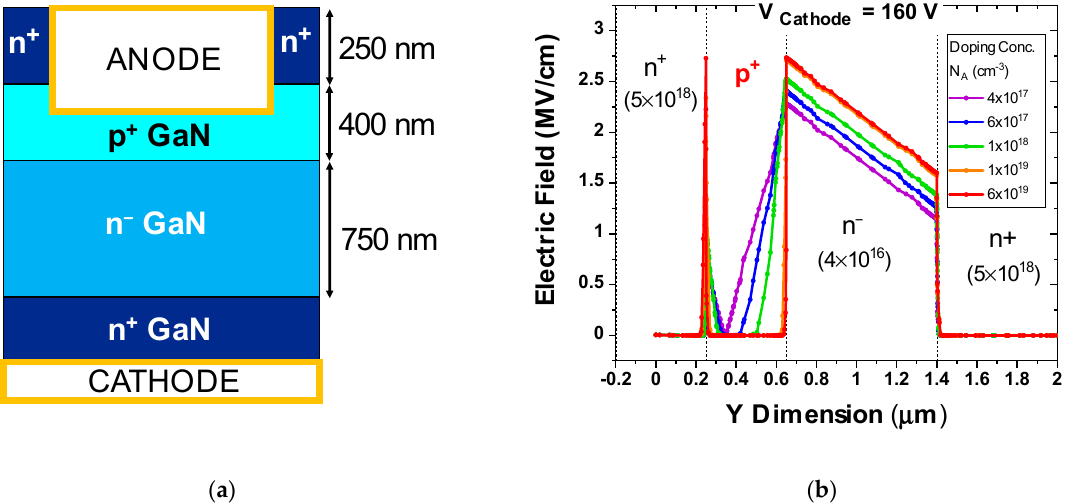
Figure 9. ( a ) Schematic of the simulated structure. ( b ) Electric field profile along the simulated vertical p + n diode for N A = 4 × 10 17 cm − 3 , 6 × 10 17 cm –3 , 1 × 10 18 cm − 3 , 1 × 10 19 cm − 3 , and 6 × 10 19 cm − 3 .